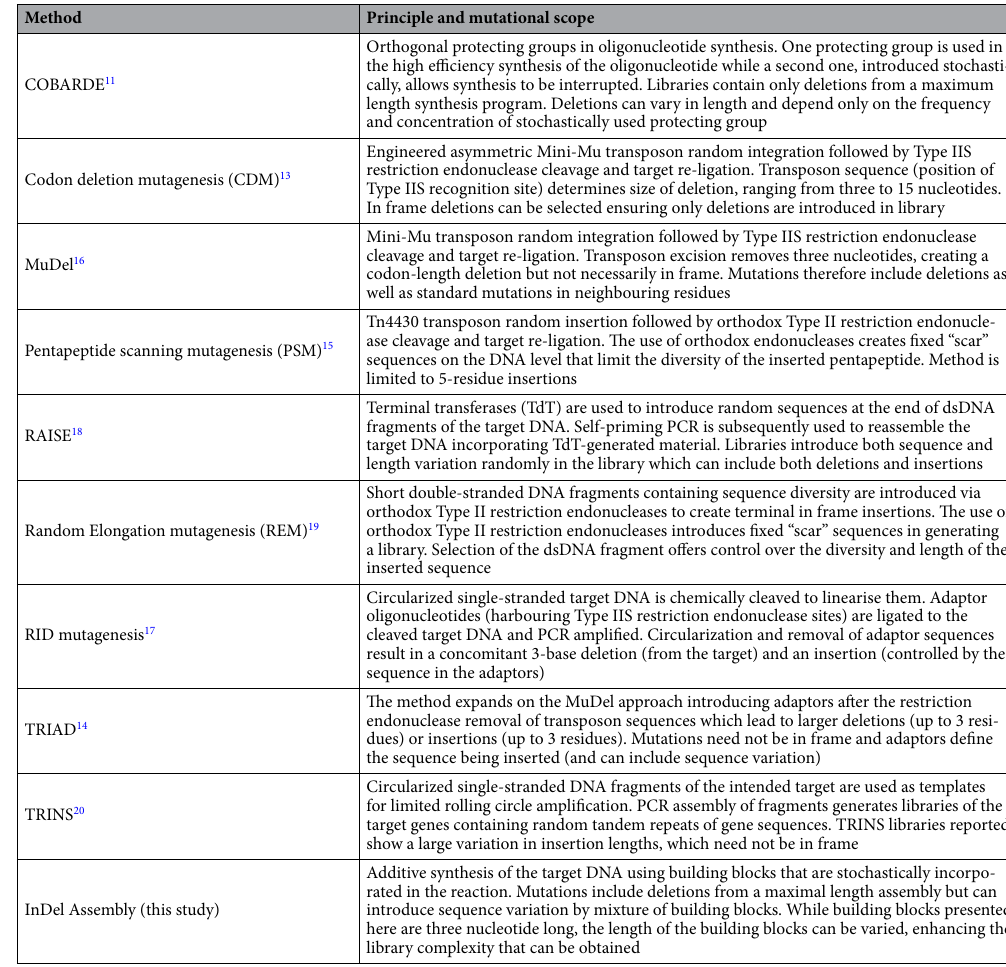
Table 1. Principle and mutational scope of a selected range of methods focused on the generation of libraries that tolerate length and compositional